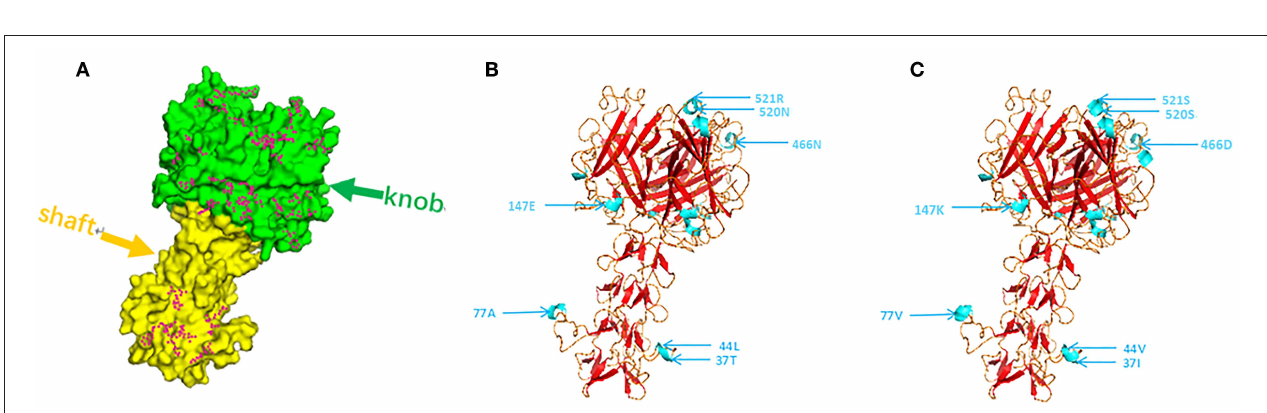
FIGURE 3 | Phylogenetic tree constructed using the complete sequences of (A) penton, (B) hexon, and (C) fiber of canine and bat adenoviruses. The phylogenetic tree was constructed using nucleotide sequences generated in this study and the sequences of CAdV-1, CAdV-2, and bat adenovirus reference strains obtained from GenBank. Bar, numbers of mutation site. Bootstrap values of > 80.0% calculated from 1,000 replicates are indicated on the respective branches. Orange background: strains isolated from Henan Province; yellow background: strains isolated from Jiangsu Province; red background: strains isolated from Hubei Province; light blue background: reference strain. The number of mutations is counted in comparison with the A26/61 strain.